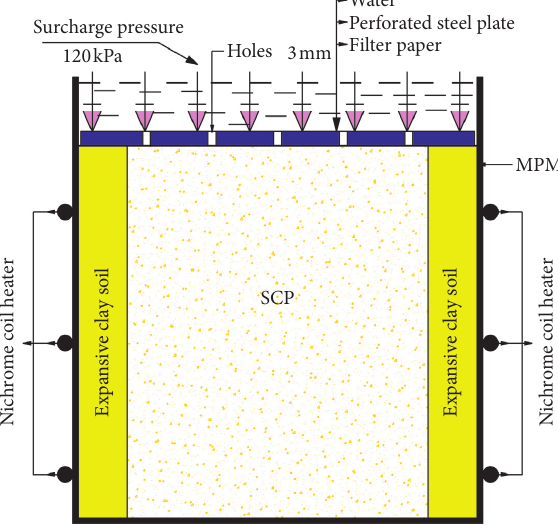
Figure 3: A vertical section of the laboratory model.